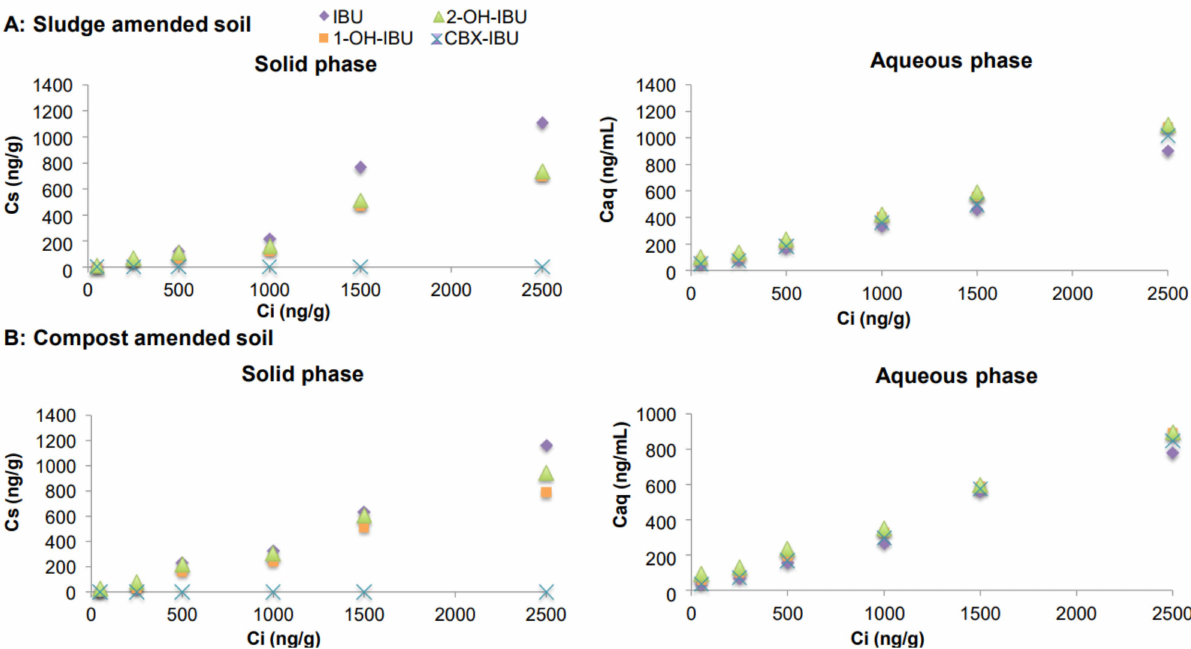
Figure 2. Concentrations of IBU and its metabolites in soil samples amended with spiked sewage sludge ( A ) and compost ( B ).